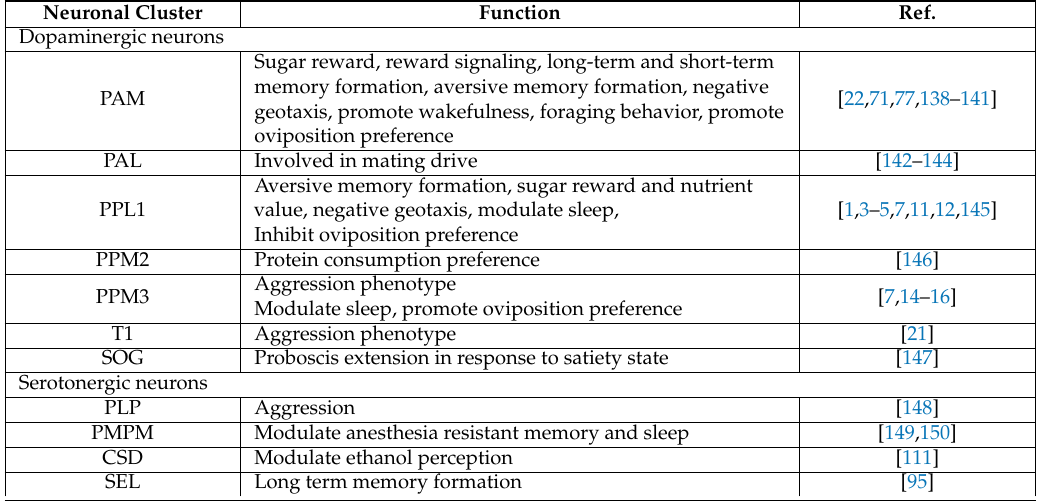
Table 1. Dopaminergic and serotonergic neurons involved in various biological functions. Neuronal Cluster